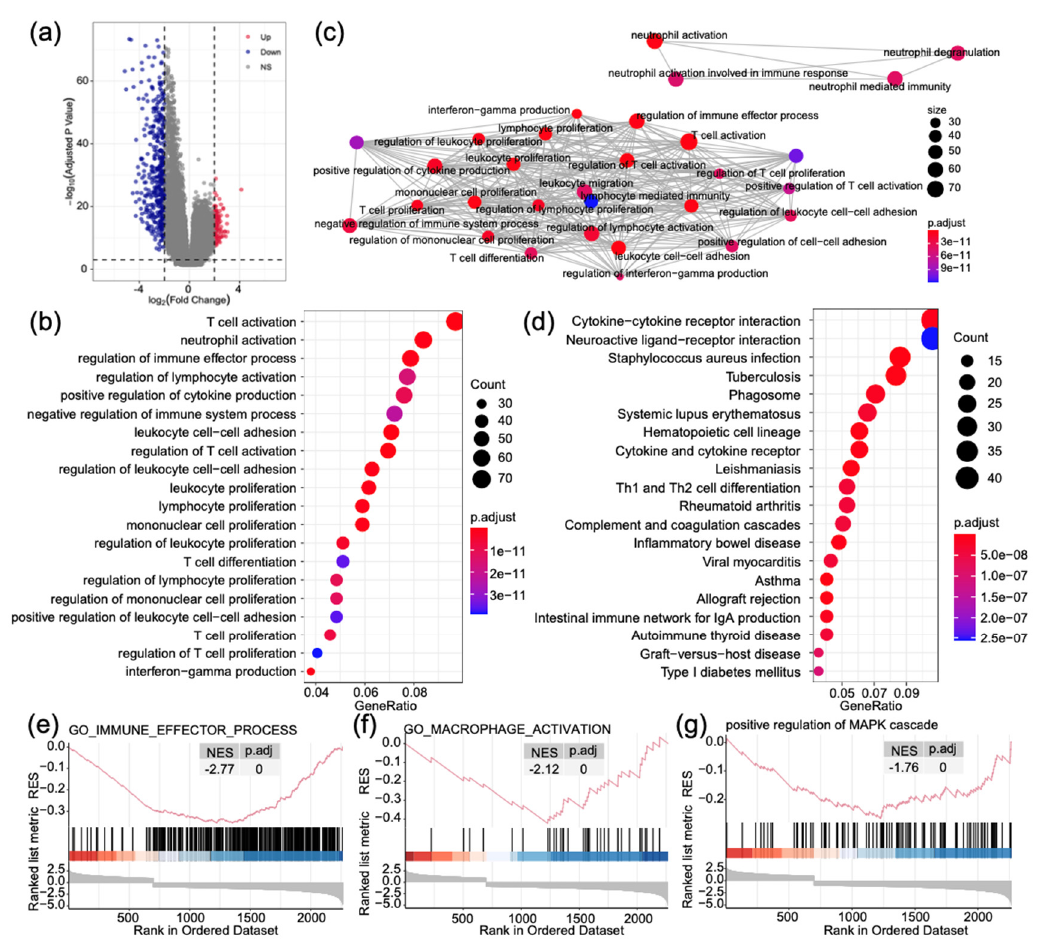
Figure 5. Gene function enrichment analysis identified biological pathways and processes associated with a high expression patient. ( a ) Volcano plot of differentially expressed genes between high- and low-expression patients. ( b ) Dot plot of gene ontology (GO) enriched terms colored by p-values. ( c ) Significant GO items were clustered according to biological function. ( d ) Dot plot of Kyoto Encyclopedia of Genes and Genomes (KEGG) enriched terms colored by p-values. ( e – g ) Gene set enrichment analysis between high- and low-expression patients. RES, running enrichment score. NES, normalized enrichment score.